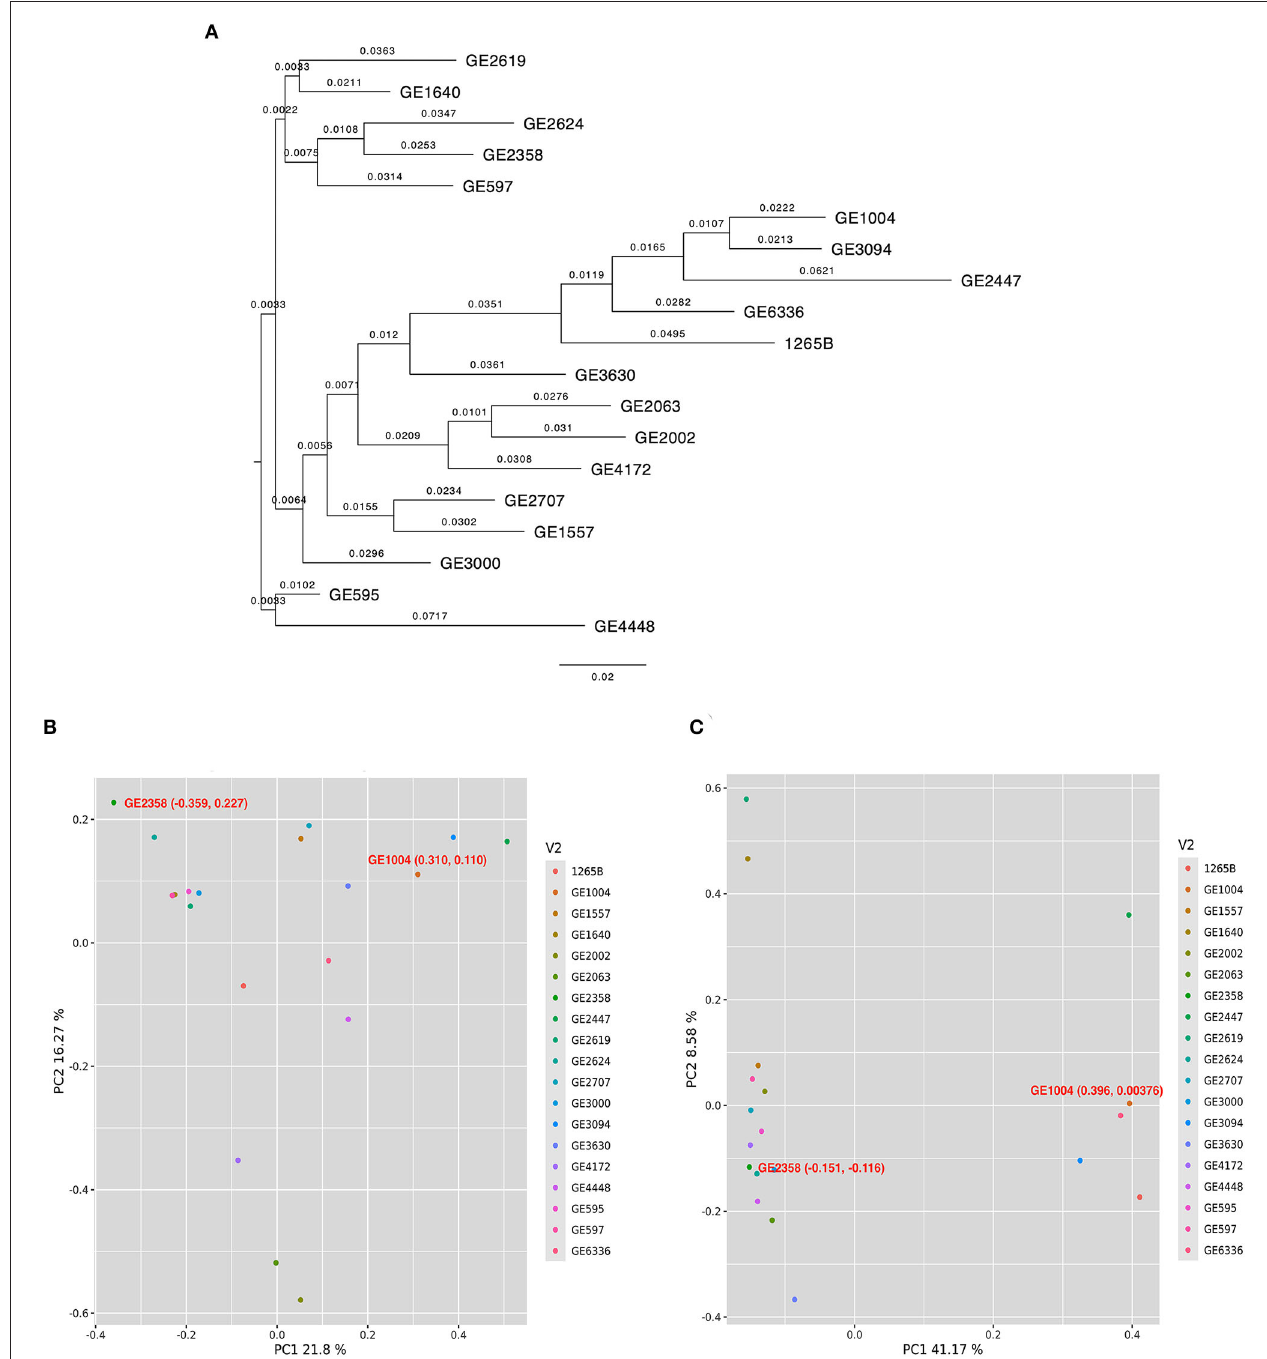
FIGURE 2 | Diversity and principal component analysis for 19 finger millet accessions. (A) Neighbor joining tree to assess the genetic relatedness among 19 finger millet accessions. Principal component analysis for 19 finger millet accessions with identified SNPs across 66 matching sequences for A sub-genome (B) and B sub-genome (C) . Filled circles with different colors in scattered plots indicate the different accessions.